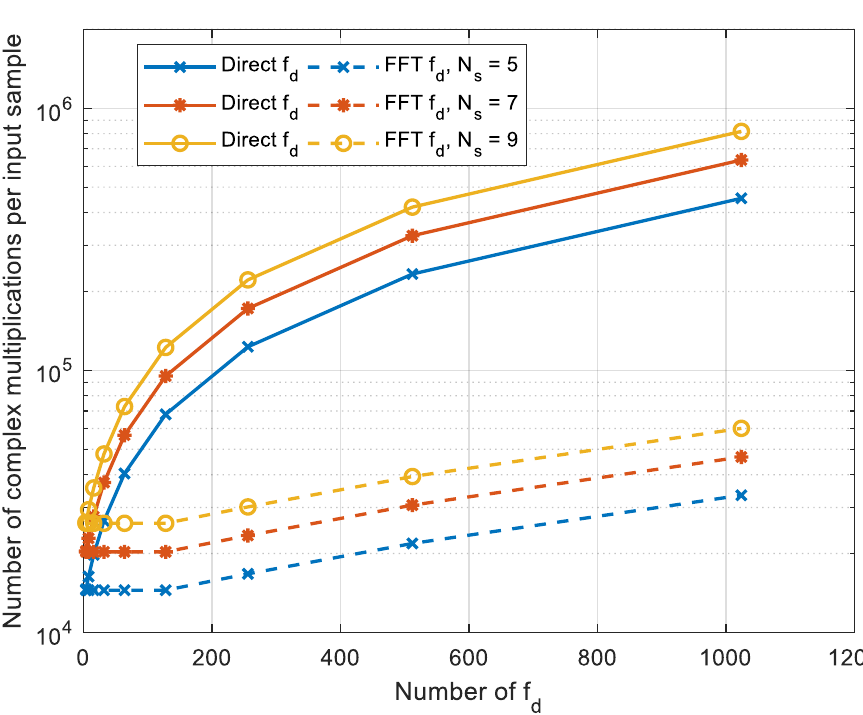
Figure 9. Dependence of the number of complex multiplications on the number of possible values f d for a different number of possible values of the slope of the dispersion characteristic of the ionospheric channel N s , M = 86, N pp = 32768.